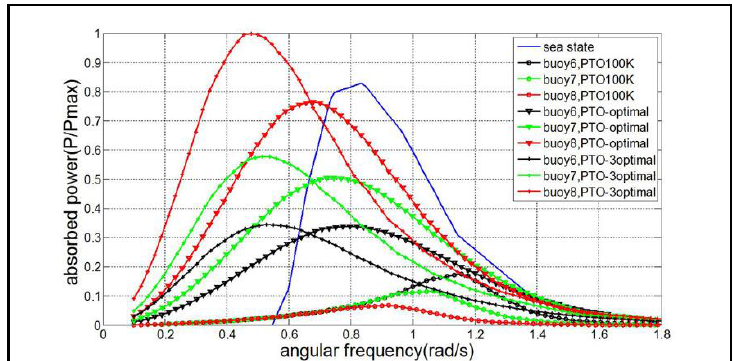
Figure 15. Absorption power spectrum with different power take-off system (PTO) dampings.